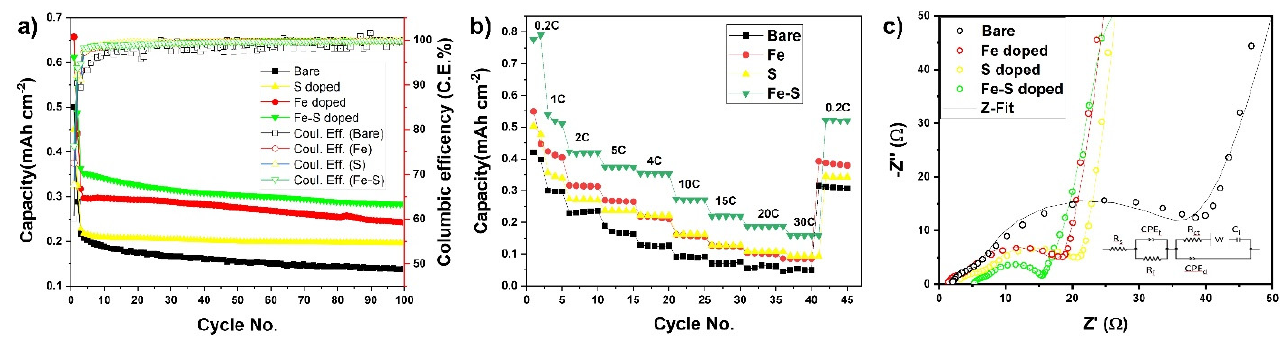
Figure 5. ( a ) Cycle vs. discharge capacity curves for bare, Fe, S, and Fe-S doped TNTs cycled at 0.5 C. ( b ) Rate capablity of bare, Fe, S, and Fe-S doped TNTs. ( c ) EIS curves of bare, Fe, S, and Fe-S doped TNTs after 100 cycles.